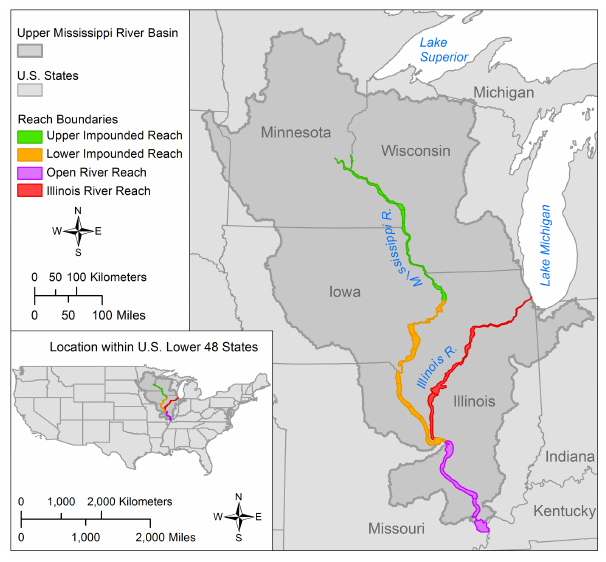
Fig. 1 . The Upper Mississippi River basin and floodplain reaches of the Upper Mississippi River